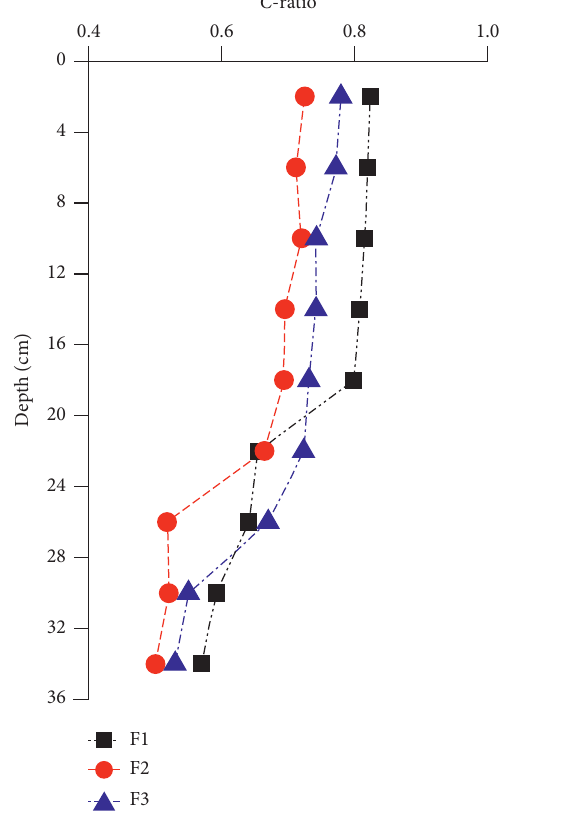
Figure 11: The internal friction angle ( A -ratio) at different depths of the expansive soil columns after the freeze-thaw